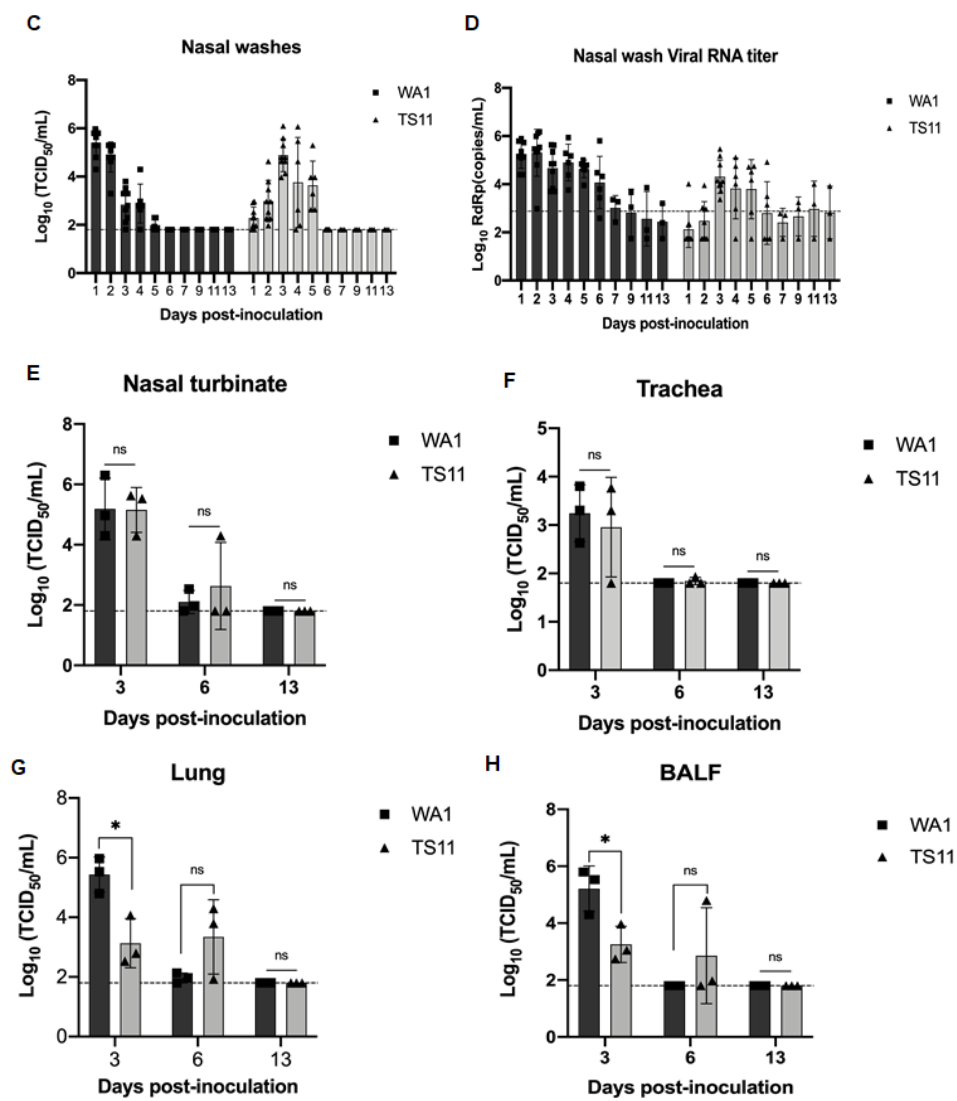
Figure 3. SARS-CoV-2 TS11 did not cause disease in Syrian hamsters even during subsequent co- infection with WA1 strain. ( A ) Schematic procedure for the Syrian hamster study. Two groups of hamsters (n = 9 per group) were intranasally (i.n.) inoculated with 4 × 10 4 PFU/hamster of SARS- CoV-2 WA1 or SARS-CoV-2 TS11. ( B ) Body weights were measured daily from 1–7 dpi followed by every two days. Nasal washes were collected daily from 1–7 dpi followed by every two days and infectious viral titers ( C ) and viral RNA titers ( D ) were determined by TCID 50 assay and RT-qPCR targeting the RdRp gene, respectively. At 3 dpi, 6 dpi, and 13 dpi, 3 hamsters per group were euthanized and the infectious virus titers in the nasal turbinate ( E ), trachea ( F ), lung ( G ), and BALF ( H ) samples were assessed by the TCID 50 assay. The dashed lines in C-H indicate the detection limit. The data were presented as mean ± standard deviations. At each time point, values of the TS11 and WA1 groups were compared by Student’s t test (*, p < 0.05; ns, not significant).